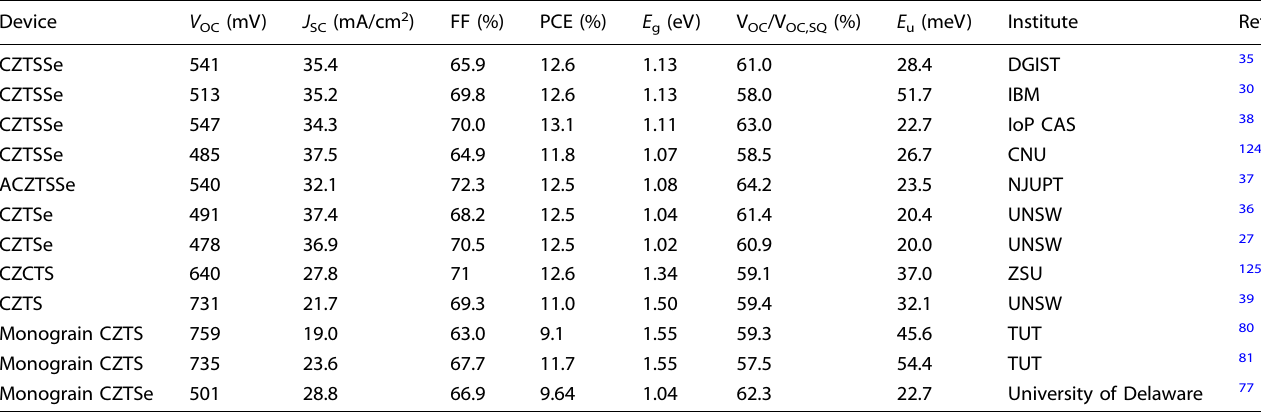
Table 2. Ef fi ciency table of representative monograin layer CZTSSe solar cells and thin- fi lm solar cells with different bandgaps.